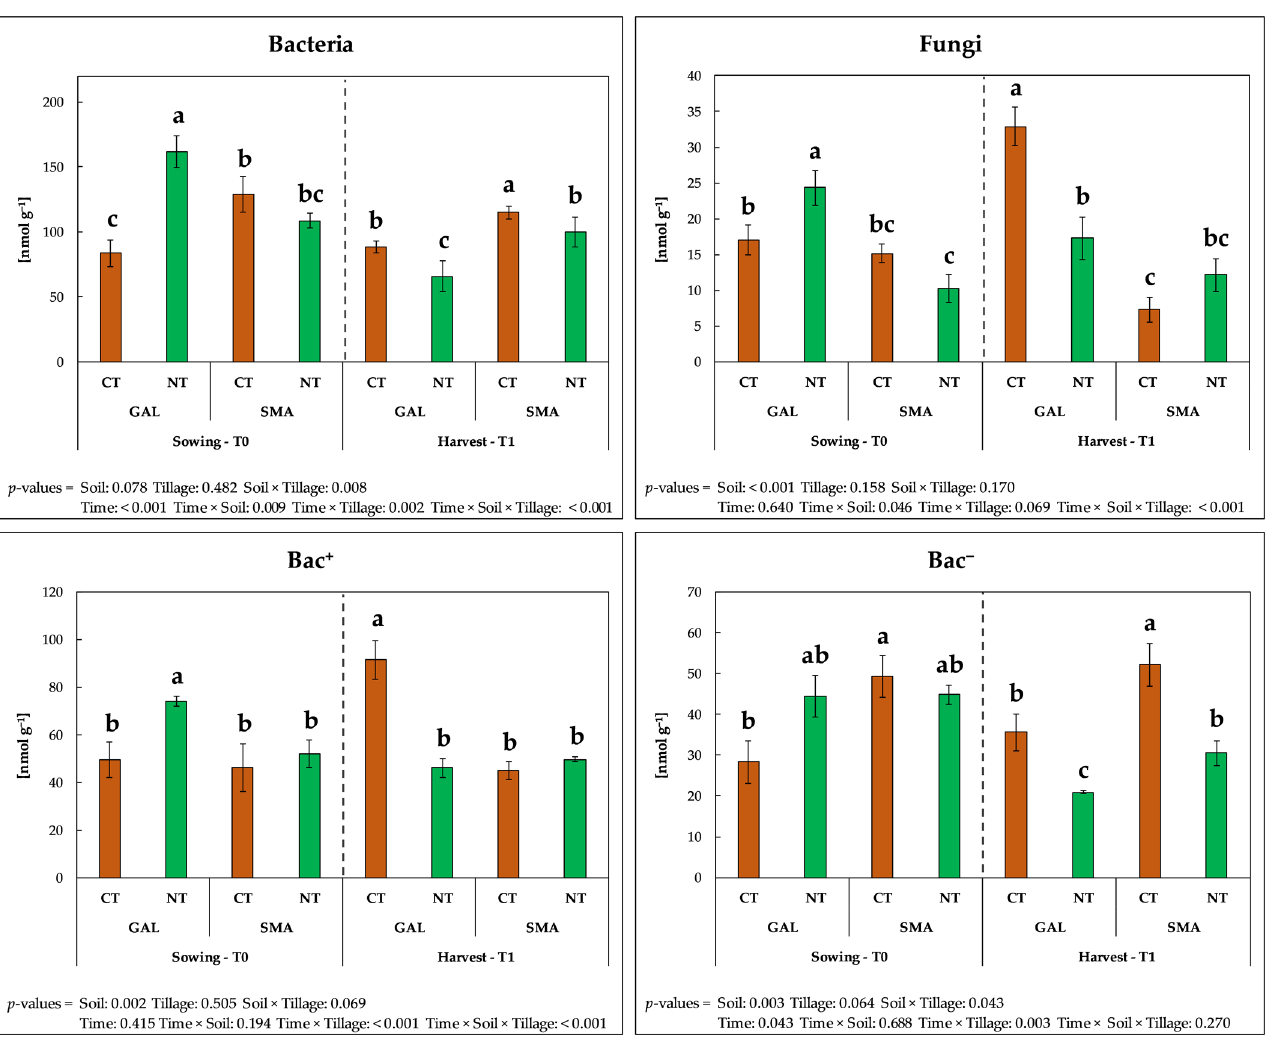
Figure 5. Effect of soil (GAL and SMA), tillage system (CT, in brown, and NT, in green), sampling time (sowing—T0 and harvest—T1), and their interaction on soil bacteria (BAC), fungi, Gram-positive (BAC + ), and Gram-negative bacteria (BAC − ) abundance. Reported values are means ( n = 4) ± SE (bars). Different letters indicate significant differences within each sampling time (Tukey’s HSD test at p < 0.05) between treatments (Soil × Tillage).